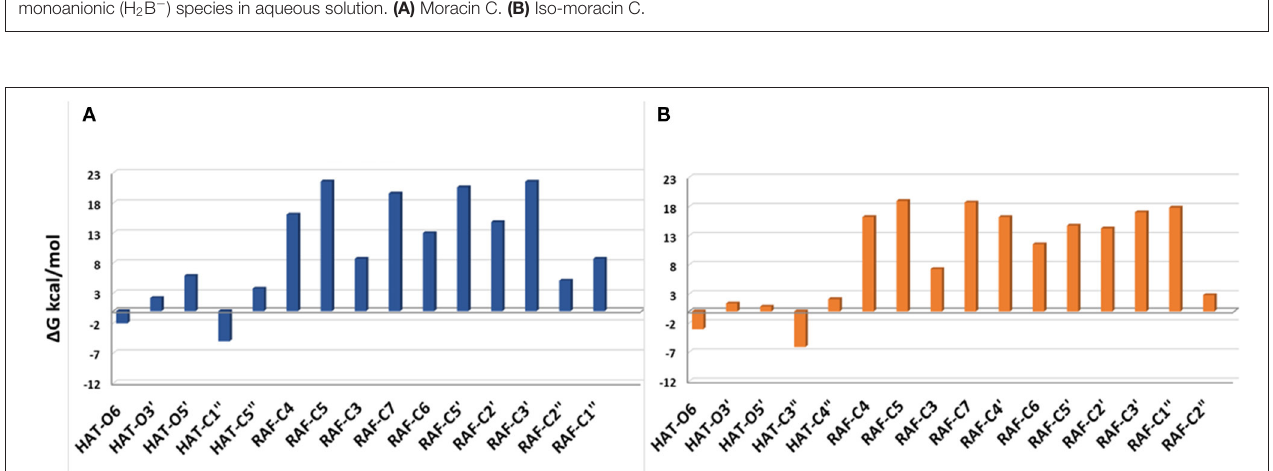
FIGURE 3 | Gibbs free energies of reaction ( 1 G kcal/mol) at 298.15K for neutral moracin C (H 3 A) and iso -moracin C (H 3 B) in pentyl ethanoate solvent. (A) Moracin C. (B) Iso-moracin C.